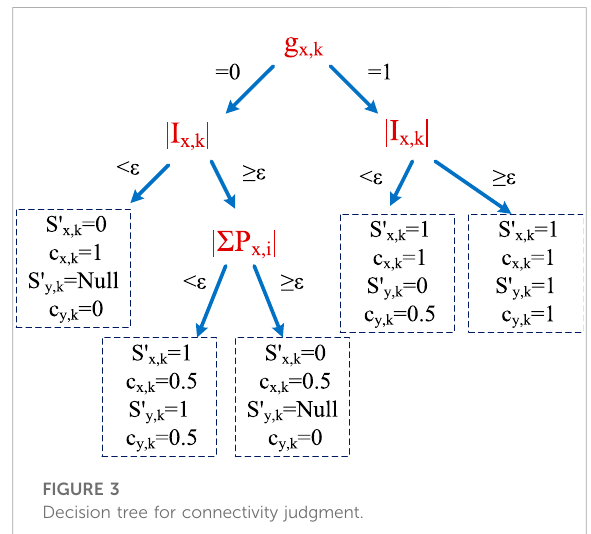
FIGURE 3 Decision tree for connectivity